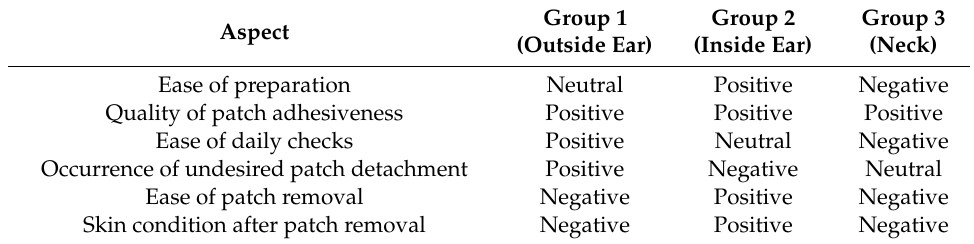
Table 1. Assessment of the practicability for the di ff erent locations. For each criteria, a subjective three level scoring system (positive, neutral and negative assessment) comparing the three groups was